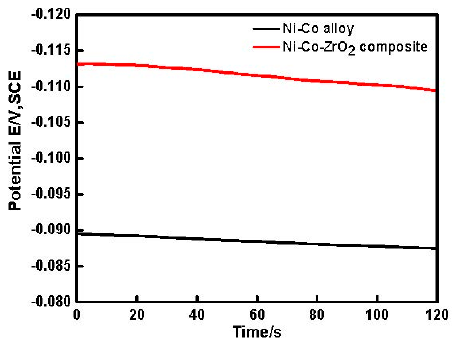
Figure 2. Open circuit potential curves of Ni-Co alloy and Ni-Co-ZrO 2 composite, respectively.